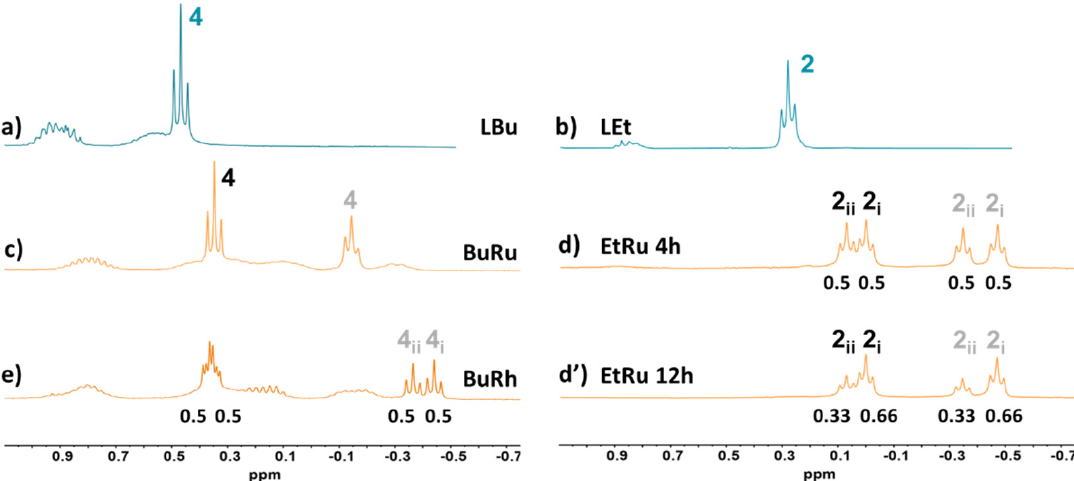
Figure 4. 1 H NMR (298 K, C = 10 − 3 M, high-field region) of: ( a ) ligand LBu in CDCl 3 ; ( b ) ligand LEt in CDCl 3 ; ( c ) BuRu in methanol-d 4 after 12 h; ( d ) EtRu in methanol-d 4 after 4 h; and ( e ) BuRh in methanol-d 4 after 12 h and ( d’ ) EtRu in methanol-d 4 after 12 h. The following nomenclature has been used: protons 4 correspond to terminal CH 3 from butyl chains and protons 2 correspond to terminal CH 3 from ethyl chains; grey and black assignments correspond to inner and outer cavity protons respectively; i and ii denote the proper signatures of the AA/CC enantiomers and the AC meso derivative respectively; 1 and 2 are used to differentiate the diastereotopic aliphatic protons (SI).